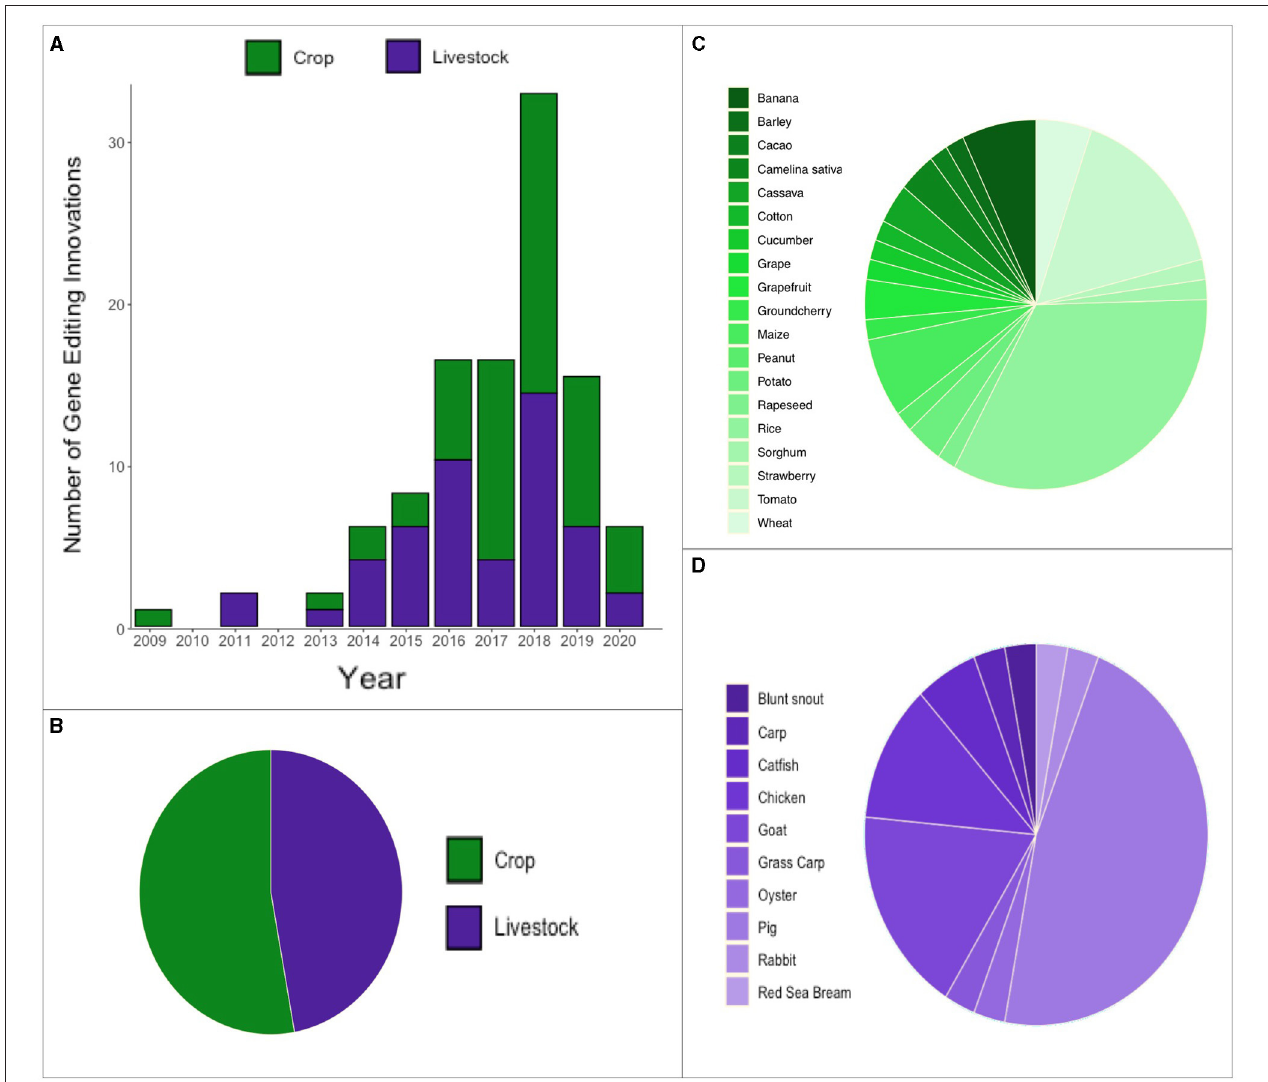
FIGURE 3 | Overview of gene editing innovation emergence over time and species. (A) Annual count of gene editing innovations since 2009. (B) Proportion of gene editing innovations (B) in crops and livestock (C) a diverse array of crops (D) a diverse array of